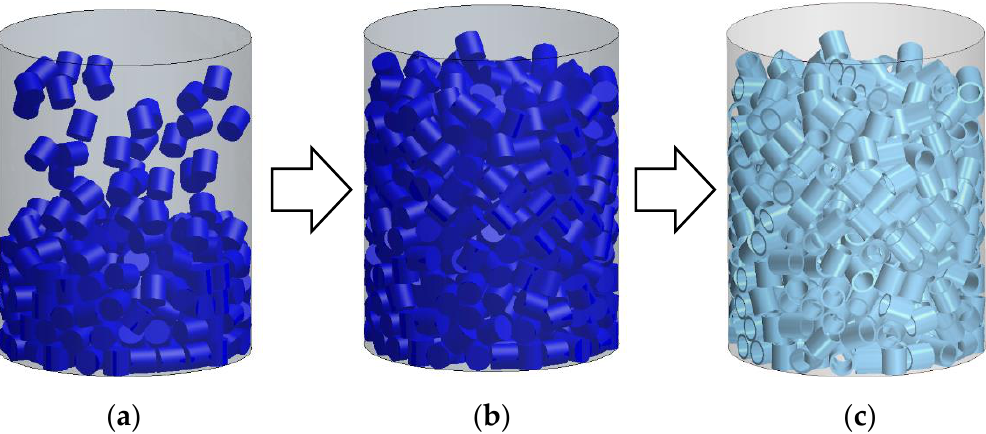
Figure 10. Schematic of the DEM procedure for the RR matrix generation in a cylindrical sample, as implemented in STAR-CCM+ [23]. a ) DEM particles injection phase; b ) DEM particles compact matrix; c ) definitive matrix after the replacement of the particles with RR.